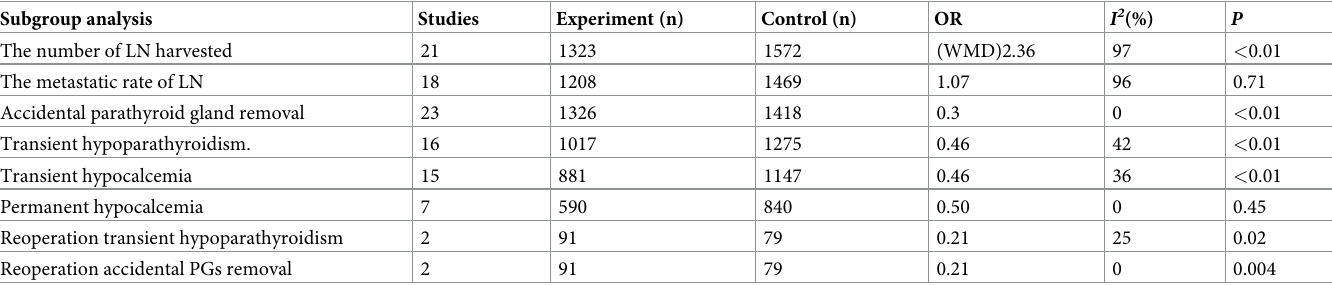
Table 2. Summary for subgroup analysis in the